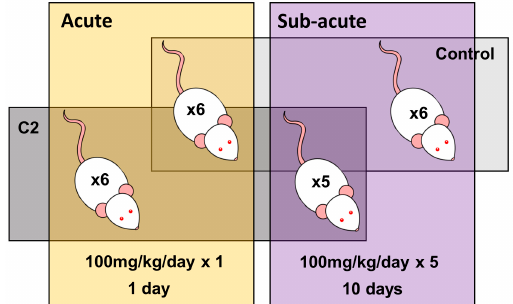
Figure 1. Experimental design. Twenty-three adult male Sprague-Dawley rats were divided into 2 experimental groups. The acute treatment group was treated with a single dose of either 100 mg/kg C2 dissolved in vehicle, or vehicle alone, with liver samples collected 1 day after treatment. The subacute treatment group was treated with repeated doses (daily for 5 consecutive days) of either C2 (100 mg/kg) or vehicle, with tissue samples collected 10 days after the initial treatment.